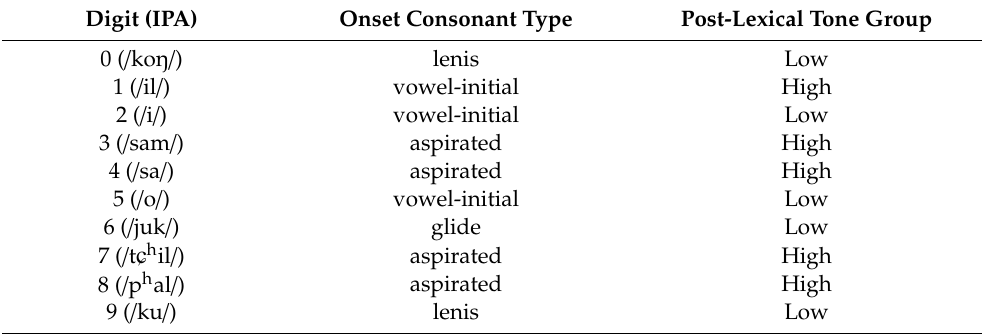
Table 1. The onset consonant type of each digit and the tone group depending on the tonal contrast that each digit